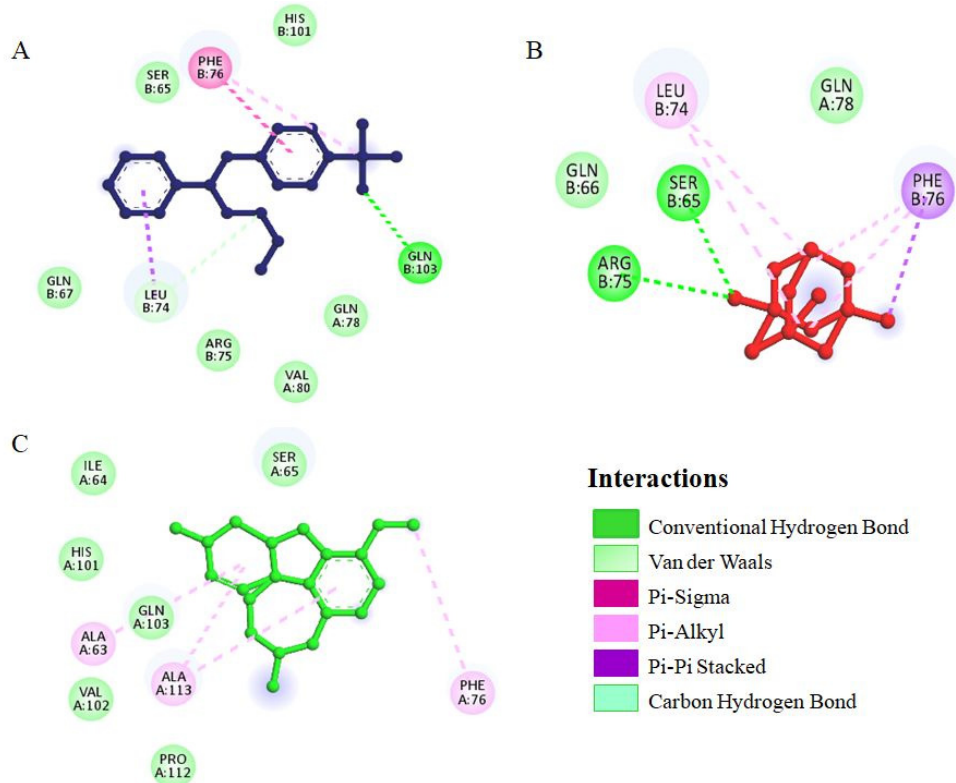
Figure 7. Two-dimensional structural representation of irisin residues interacting with ( A ) Fluoxetine ( B ) Memantine, and ( C ) Galantamine.